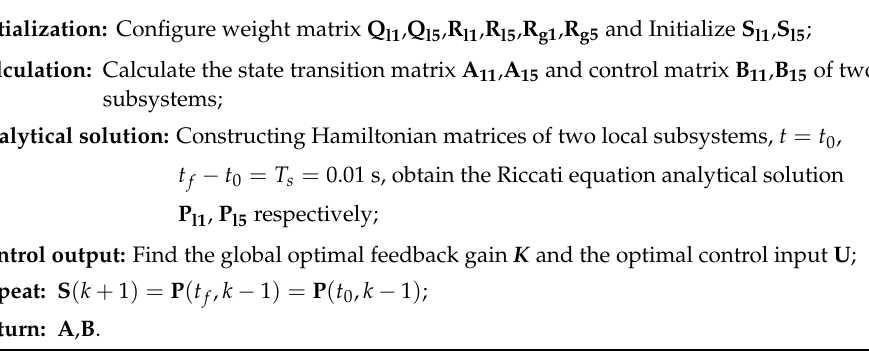
Algorithm 1: HLQR